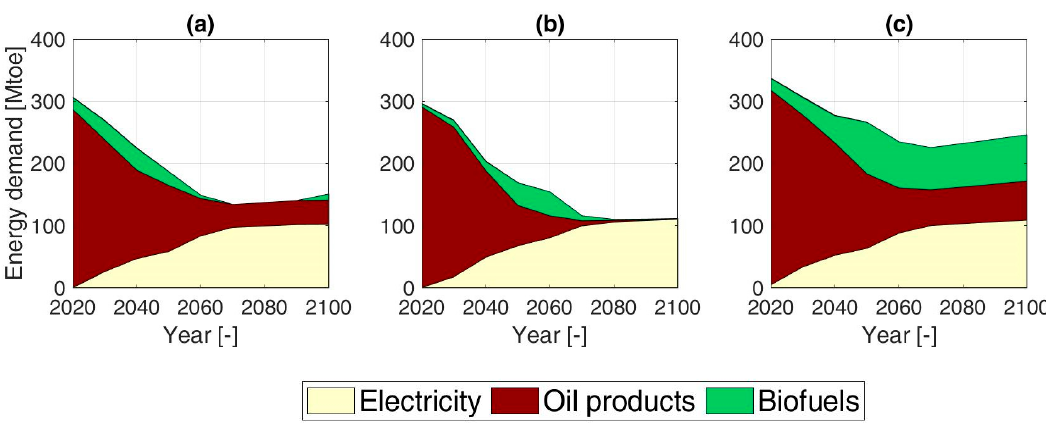
Figure 8. Road transport energy demand per type of fuel: storyline A ( a ), B ( b ) and C ( c ), respectively.